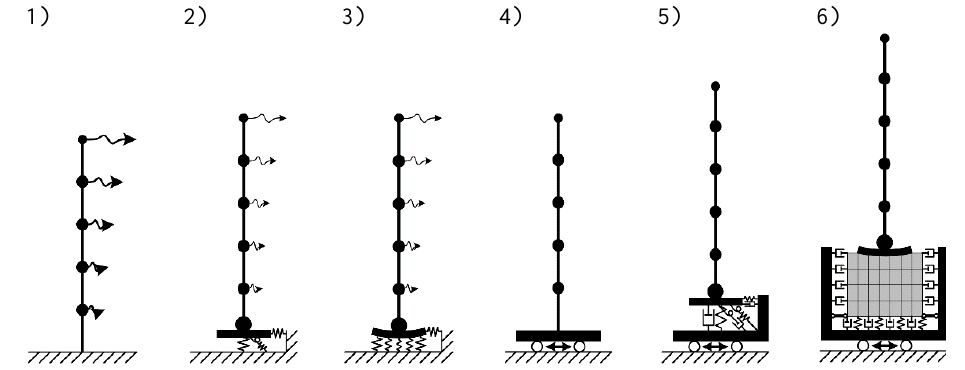
Fig. 4. Types of Soil-Structure Interaction models in SCAD Office